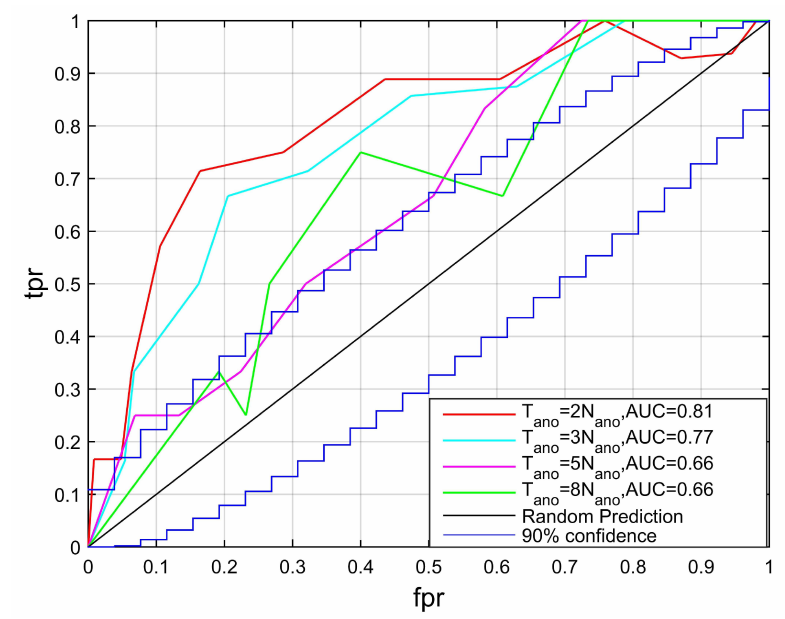
Figure 10. ROC prediction of different proportions of N ano to T ano .